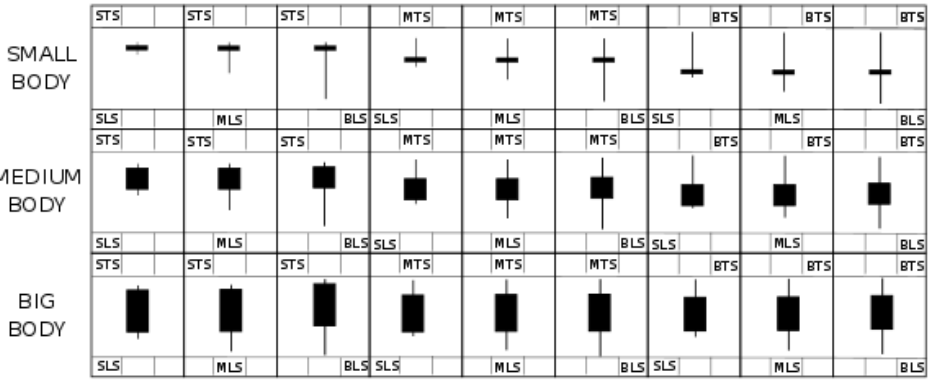
Figure 6. Each box is identified by the size of each parameter defining the single-candlestick pattern. In the upper area of each box, we read the size of the top shadow (STS, MTS and BTS for small, medium and big sizes, respectively). Similarly, we find the information about the lower shadow in the lower part of each